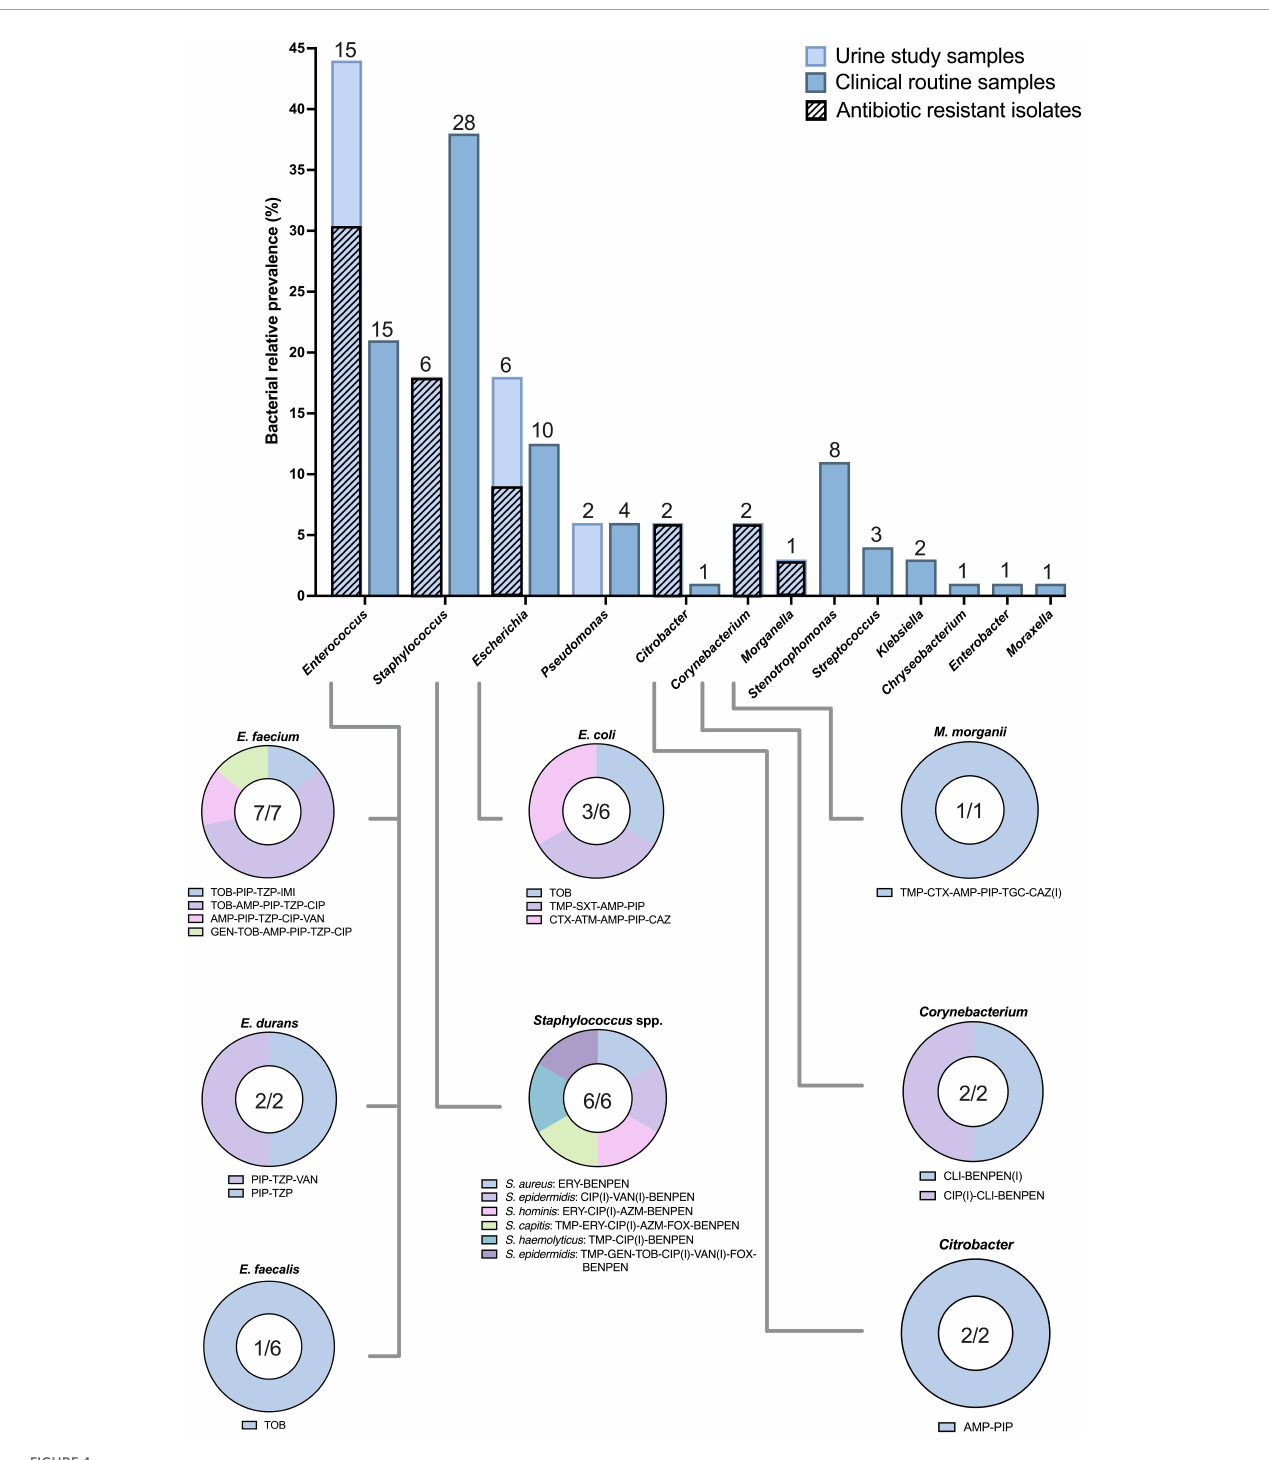
FIGURE4 Relative prevalence and antibiotic resistant isolates. The relative prevalence of identified bacteria in urine study samples (bright blue) and any positive clinical routine sample (dark blue). The number above the bar shows the number of bacteria where each species is counted maximum once per patient. Diagonal patterns (bright blue bars) indicate resistance against at least one tested antibiotic. The lower panel illustrates identified resistant phenotypes, with the number within the circle graph showing the number of resistant bacteria in relation to the total number identified. Abbreviations for antibiotics can be found in Supplementary Table 1